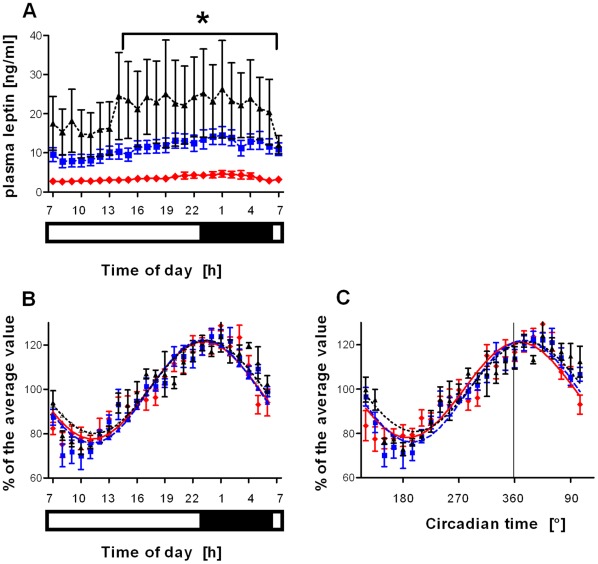
Diurnal rhythms of plasma leptin concentrations.(a) Analysis of absolute concentration revealed a significant effect of group (p<0.001; 2-way repeated measures ANOVA) but not of time or time x group interaction. *p<0.05 lean vs type 2 diabetic subjects. (b–c) Following normalisation of each individual’s raw data to their own mean concentration, the group values were calculated and fitted with a cosinor curve. Normalised data are expressed relative to (b) external time of day and (c) endogenous circadian time, estimated using DLMO where 360°  =  time of DLMO. The DLMO of two participants in the type 2 diabetic participant group could not be calculated due to the absence of a peak in the melatonin profile; their data were thus excluded. Statistical analysis showed a significant effect of time (p<0.001; 2-way repeated measures ANOVA) but not for group or interaction in both (b) and (c). (a–b) The light-dark conditions are indicated by the bars below the x-axes. In all panels, diamonds, solid red line  =  lean subjects (n = 8); square, dashed blue line  =  obese non-diabetic subjects (n = 10); triangle, dotted black line  =  type 2 diabetic subjects (n = 7).